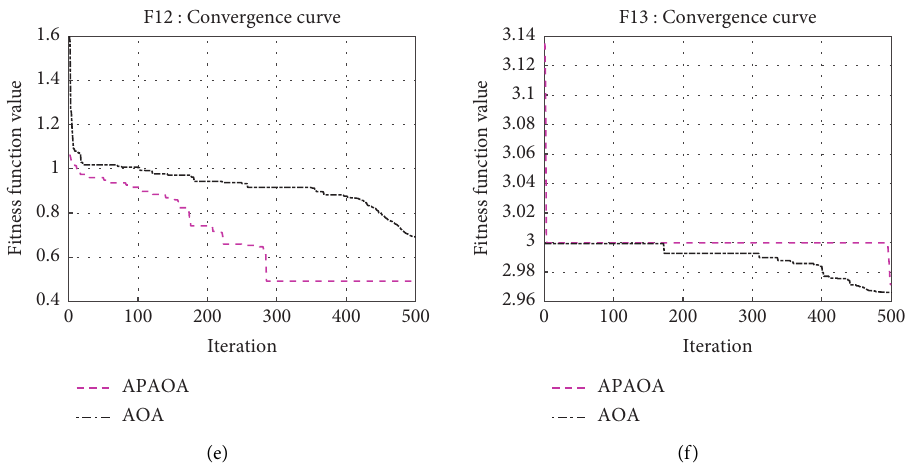
Figure 4: Comparison of convergence curves between APAOA and AOA in F8–F13.